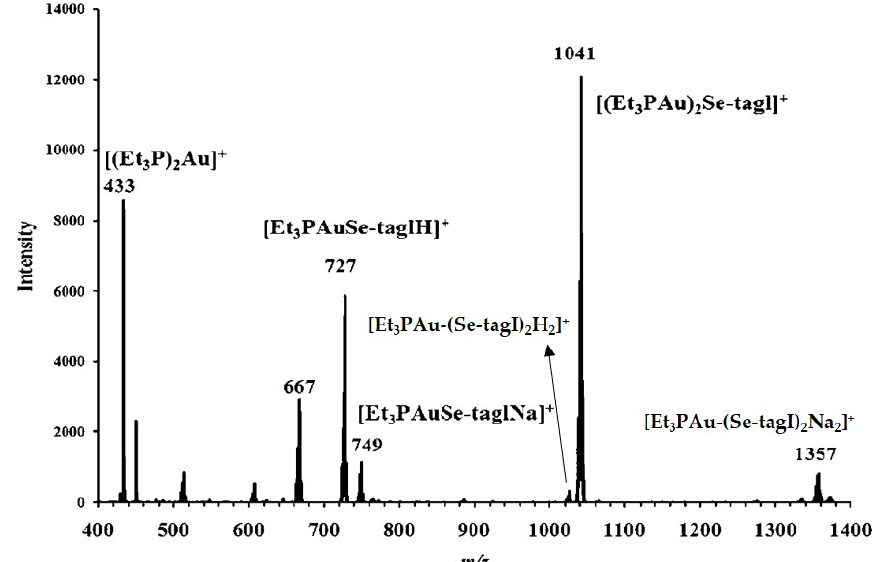
Figure 15. The ESI-MS spectra for the speciation of 10 mM SeAF (Et 3 PAuSe-tagl) in a 1:1 MeOH:H 2 O solution mixture [109]. Adapted with permission from Hill, D.T.; Isab, A.A.; Griswold, D.E.;